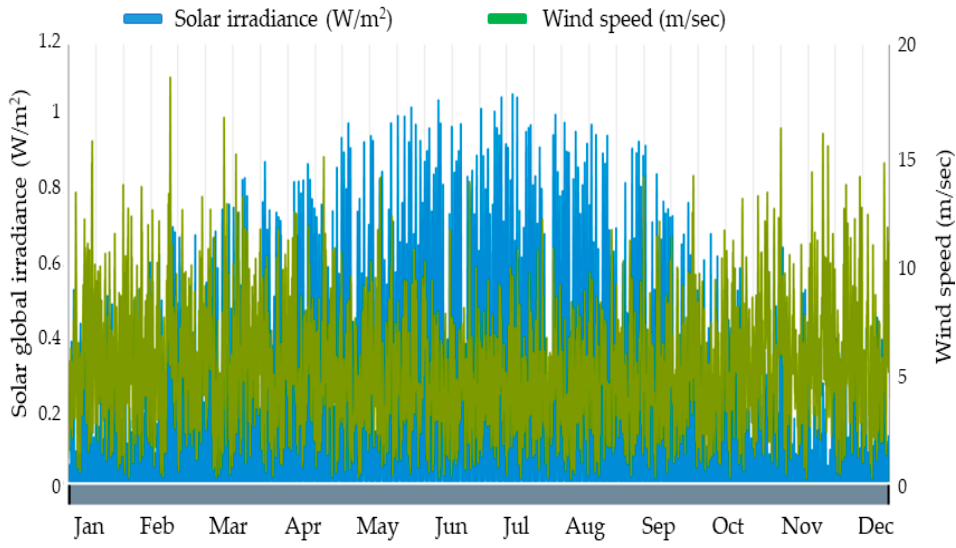
Figure 3. Solar and wind energy resources at the selected location.